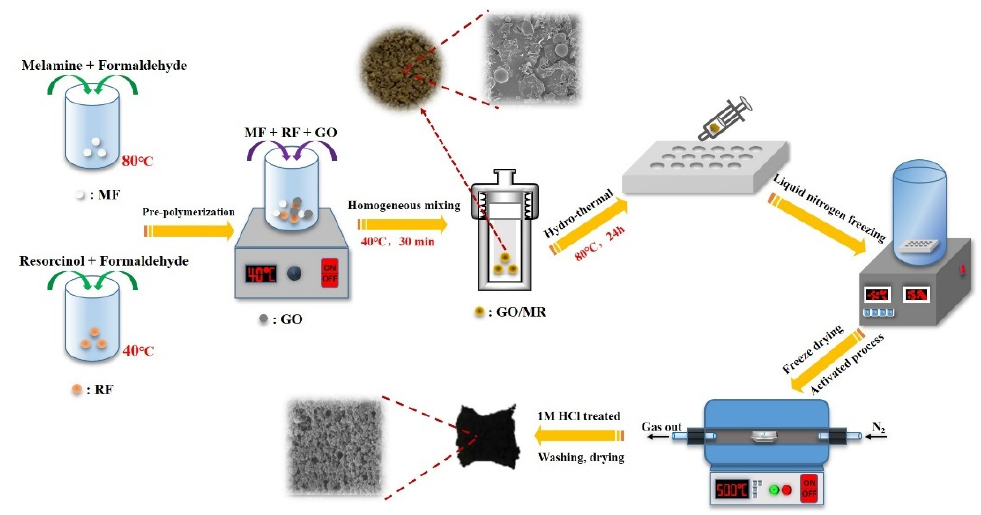
Figure 1. Schematic illustration of the synthesis process of nitrogen-rich porous carbon materials derived from GO/MR composite.